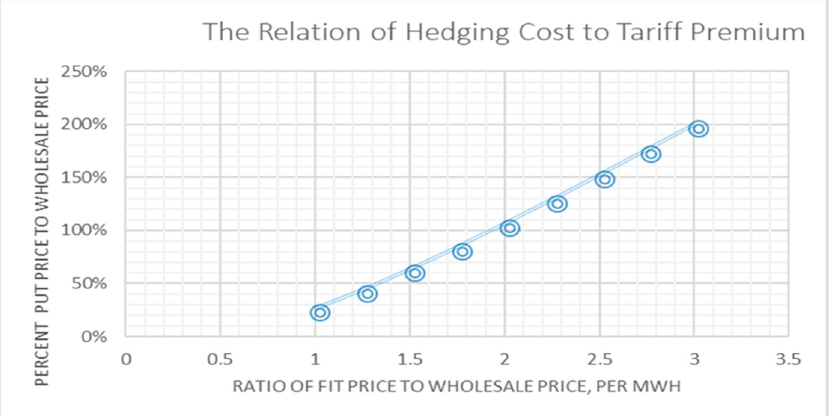
Figure 4. The Relation of Hedging Cost to Tariff Premium (source: author’s calcula- tions using DerivaGem© Software [1]).